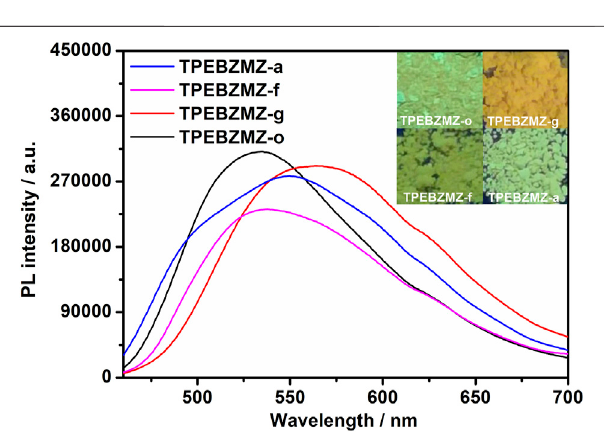
FIGURE2| FluorescencespectraandimagesofTPEBZMZ:TPEBZMZ- o, the original powder; TPEBZMZ-g, ground powder from TPEBZMZ-o; TPEBZMZ-f, CH 2 Cl 2 -fumed (2 h) powder from TPEBZMZ-g; TPEBZMZ-a, annealed (240 ° C, 1 h) powder from TPEBZMZ-g.